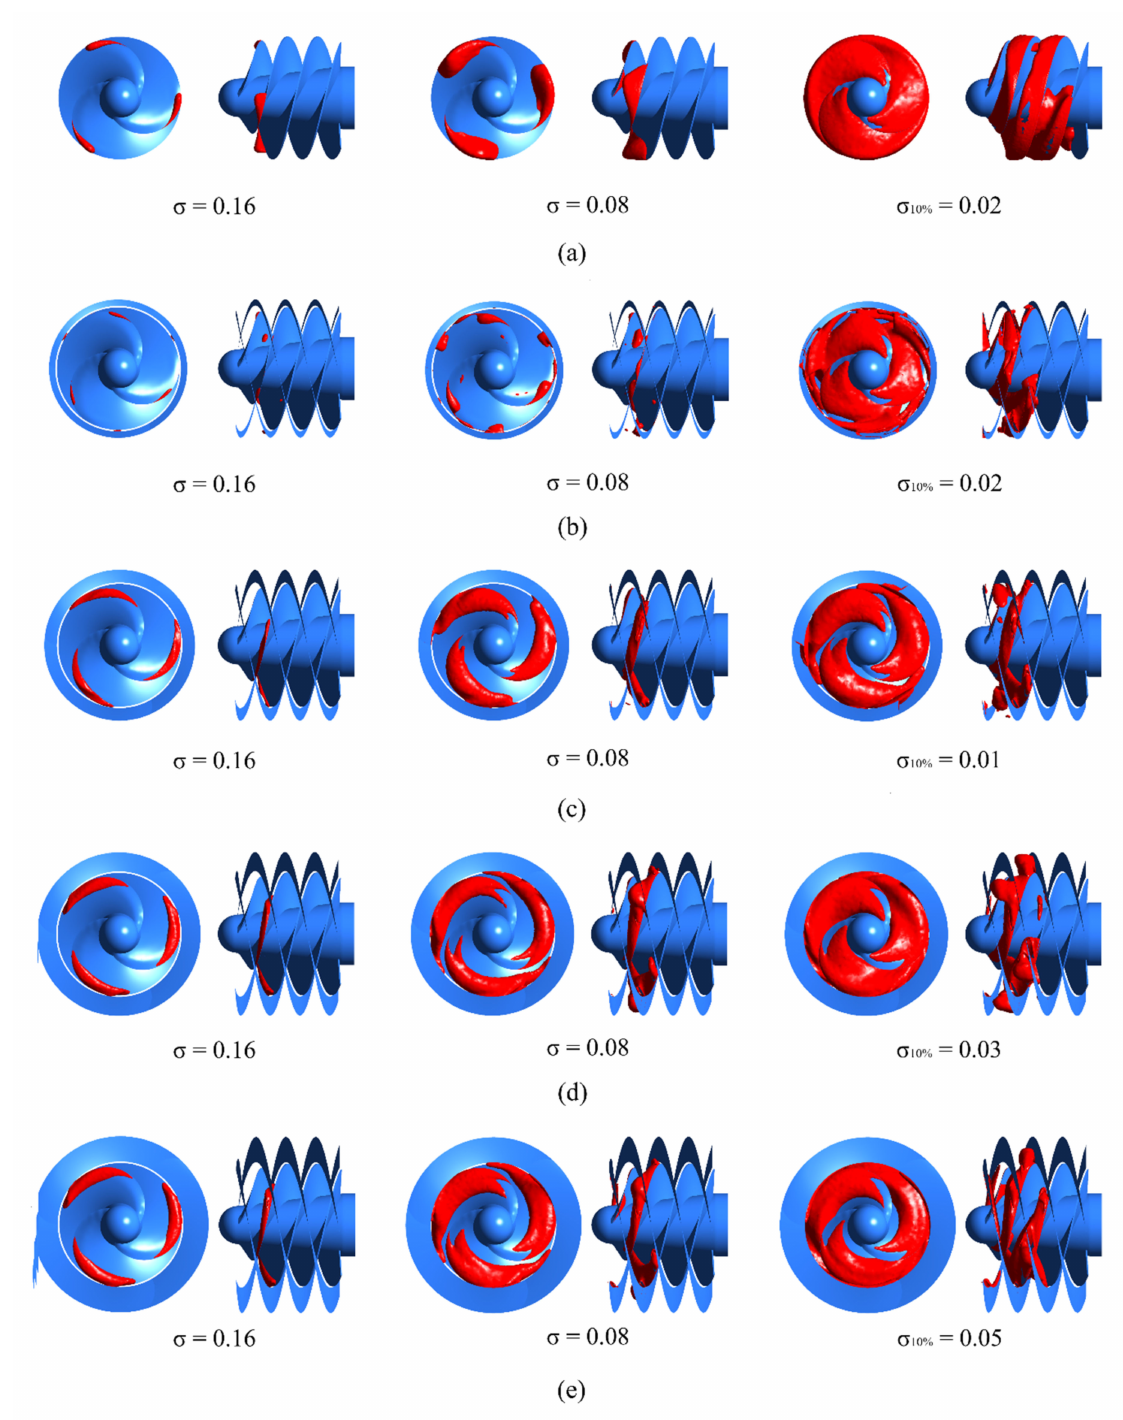
Figure 11. Bubble volume distribution under different radial heights. ( a ) inducer, ( b ) k = 0.05, ( c ) k = 0.1, ( d ) k = 0.15, ( e ) k =